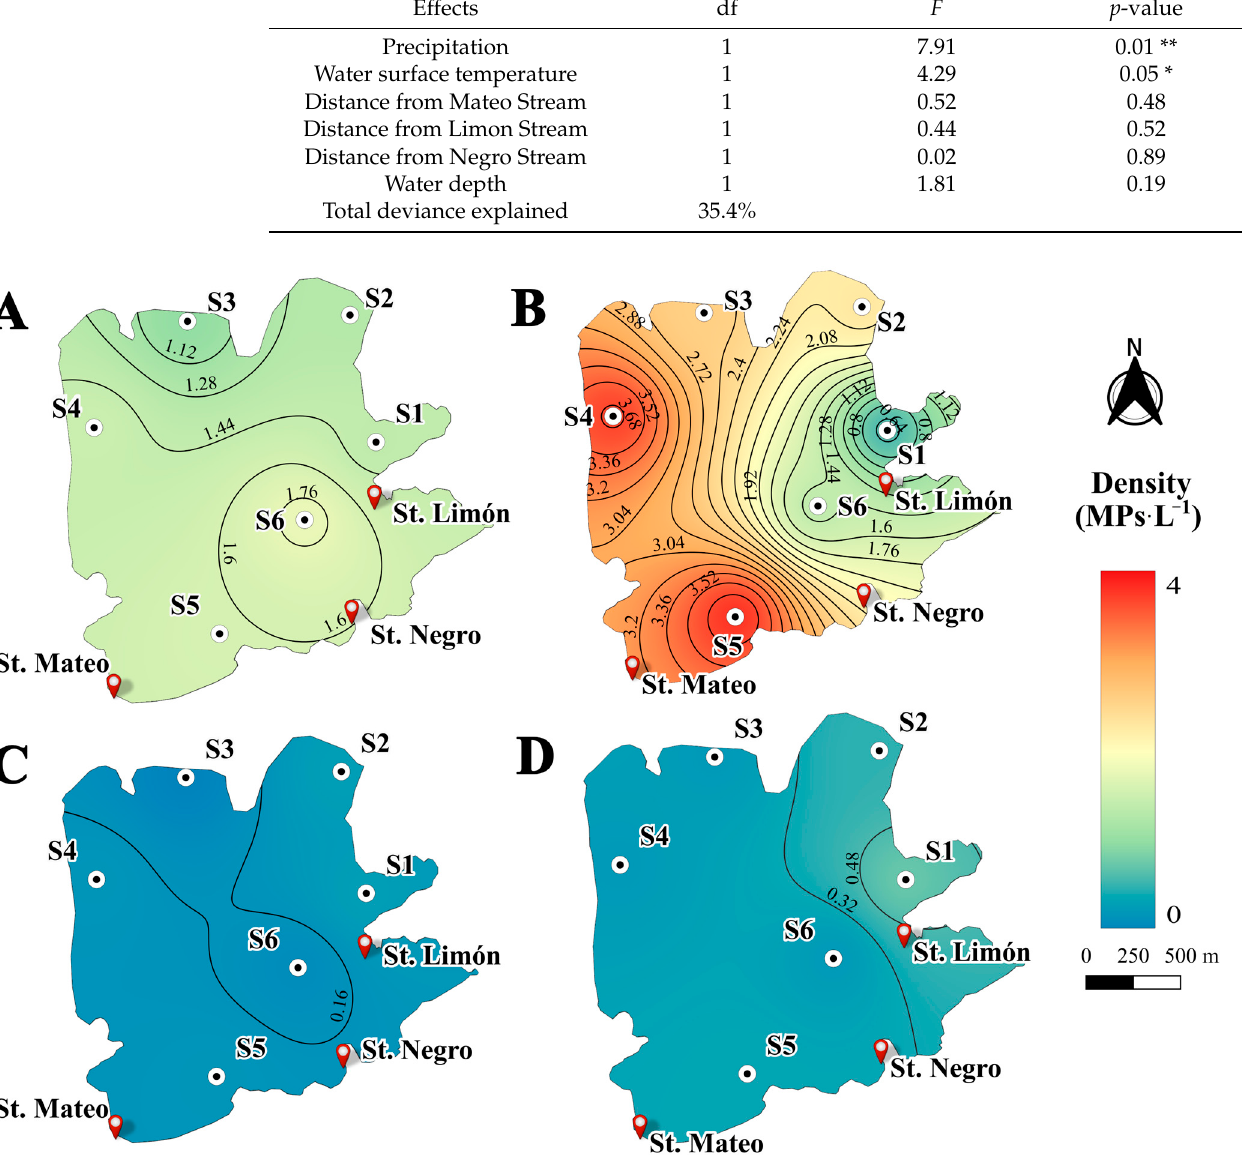
Figure 3. Density and distribution of microplastics in the surface water of Luruaco Lake in the rainy season: ( A ) September 2021, ( B ) November 2021 and dry season: ( C ) March 2022, ( D ) May 2022.